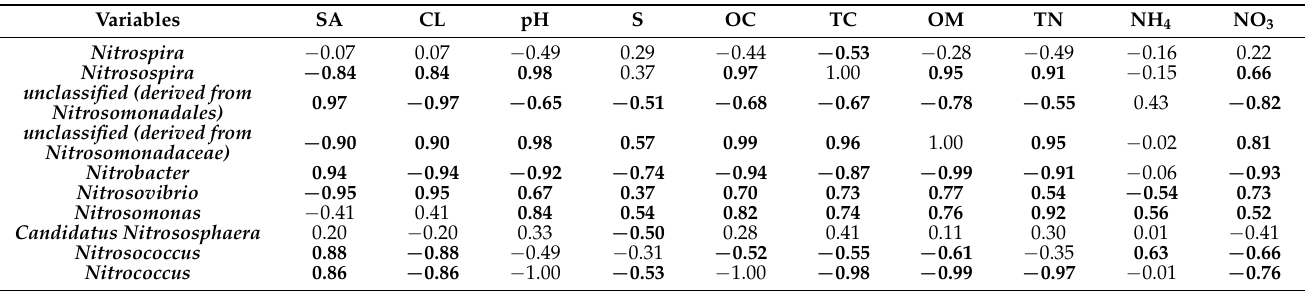
Table 5. Pearson’s correlation coefficient (r) matrix analysis shows the influence of environmental factors and nitrifying